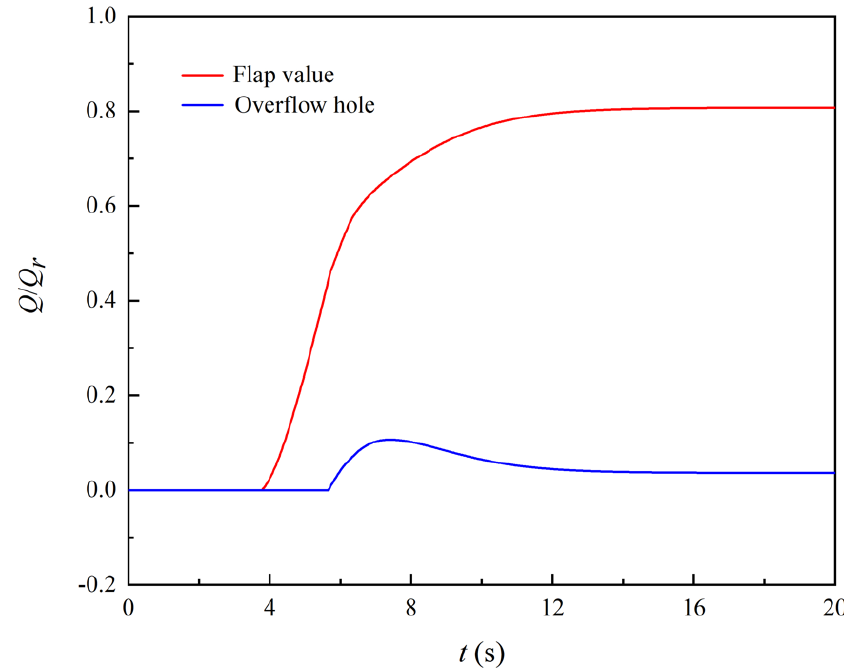
Figure 15. Flow at OVHO (1.04 H m ) and FLVA (49.1% A g ).